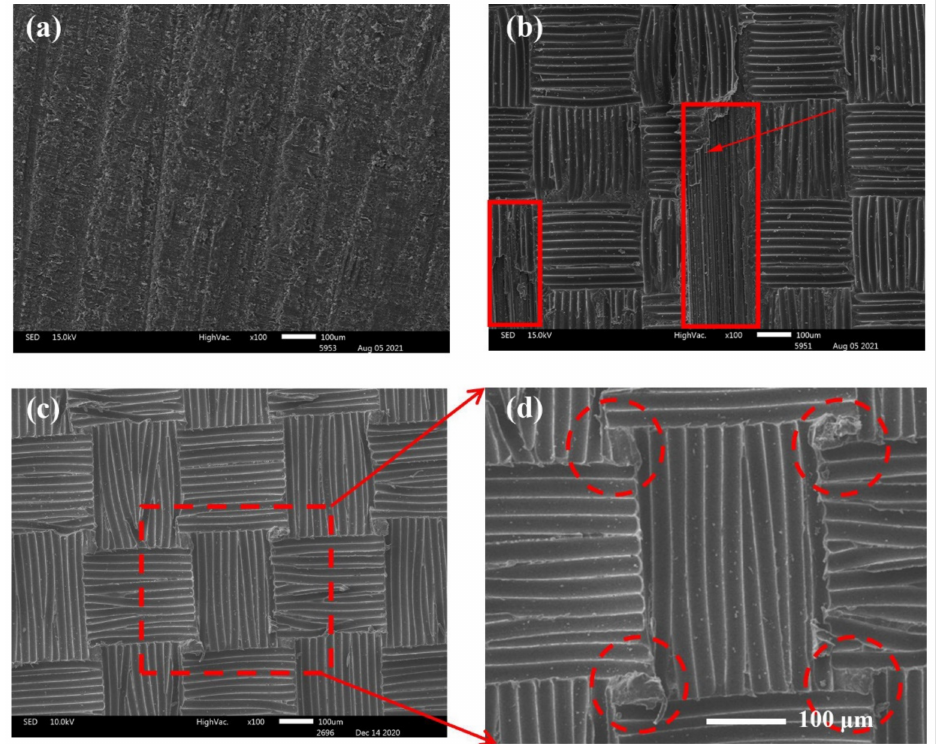
Figure 7. SEM images of composite surfaces treated using different methods: ( a ) sanding, ( b ) dry peel ply, and ( c , d ) wet peel